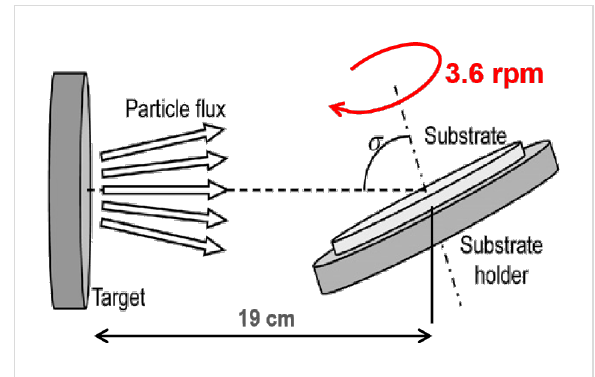
Figure 1: Scheme of the sputtering process with glancing angle depo- sition and rotating substrate.